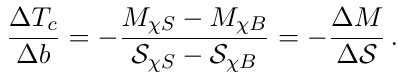
Figure 14 . The entropy S as a function of the temperature T for four di(cid:11)erent values of the chemical potential (cid:22) = 0 : 16 (blue), (cid:22) = 0 : 2 (red), (cid:22) = 0 : 23 (green) and (cid:22) = 0 : 25 (orange). The left, center and right panels correspond to b = 0 : 1, b = 0 : 2 and b = 0 : 4 respectively. and from (5.6) and (5.8) we (cid:12)nd the